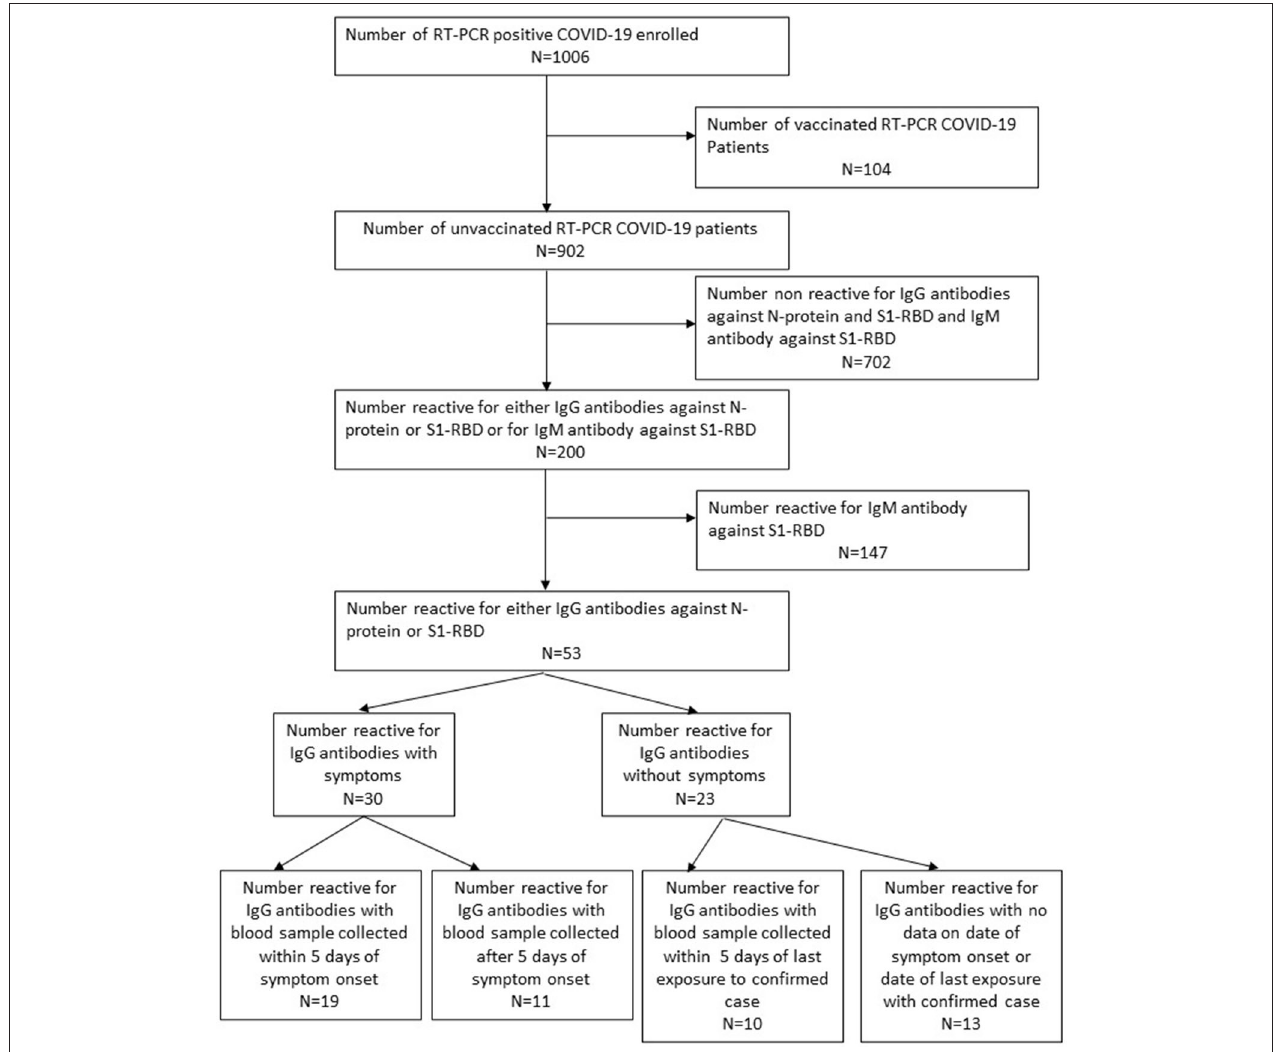
FIGURE 1 | Flow chart describing the enrolment of study participants and their serological details.